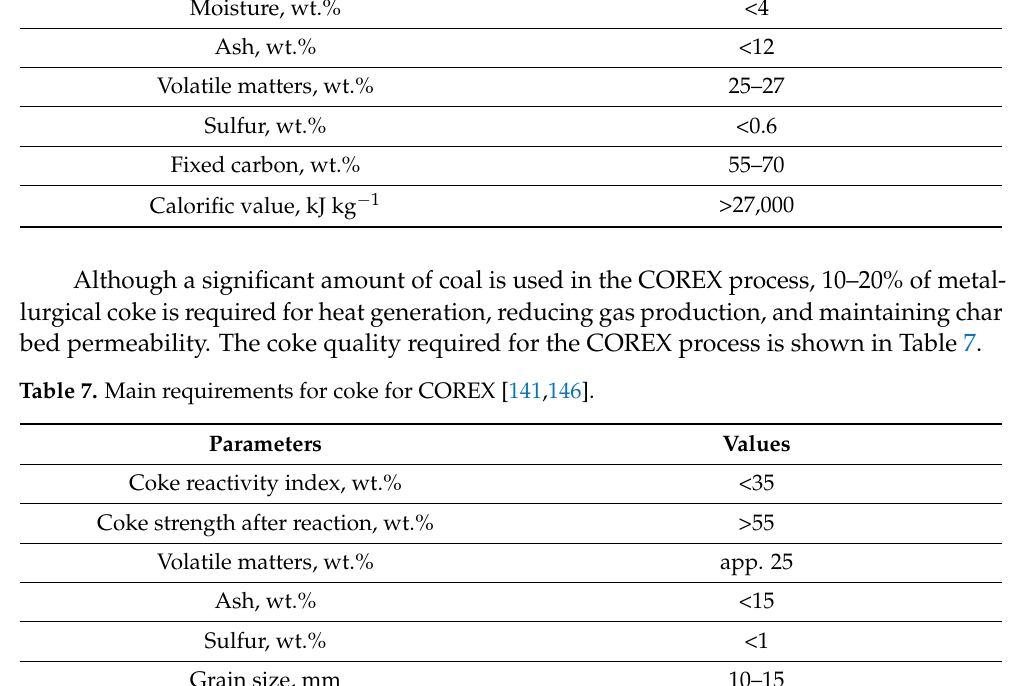
Table 6. Main requirements for non-coking coal for COREX [145]. Parameters Values Moisture, wt.% <4 Ash, wt.% <12 Volatile matters, wt.% 25–27 Sulfur, wt.% <0.6 Fixed carbon, wt.%